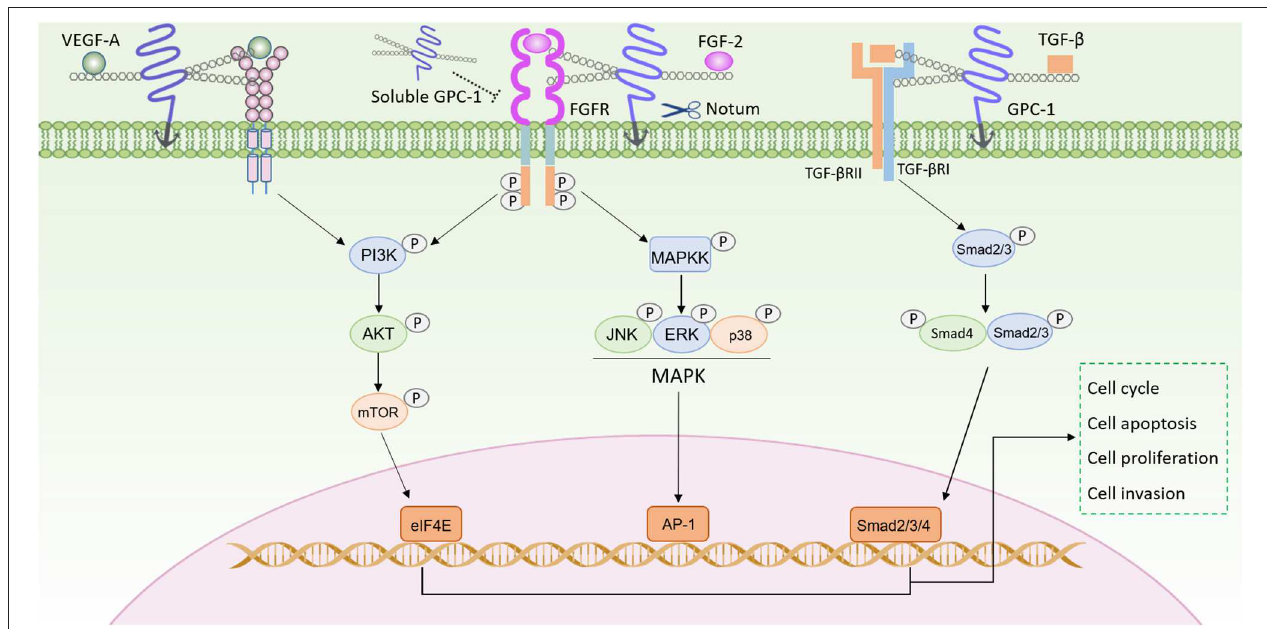
FIGURE 1 | GPC-1 modulates signaling pathways in cancer progression. The HS side chains of GPC-1 bind both growth factors (such as VEGF-A, FGF-2, and TGF- β ) and their receptors, to facilitate their assembly for enhanced signaling in PI3K/AKT, MAPK, Smad pathways. GPC-1 can be cleaved by Notum and then released into the extracellular space, which can compete with the GPC-1 anchored on the cell membrane to inhibit its function.